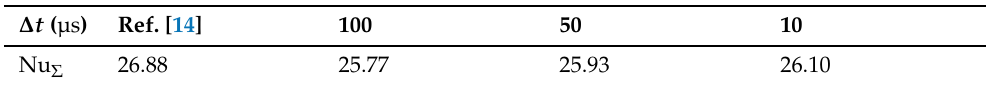
Table 4. Time step sensitivity results for LBE tube bank cross-flow at Pe m = 1.2 × 10 3 , Pr t = 0.85 and Mesh #2 from Table